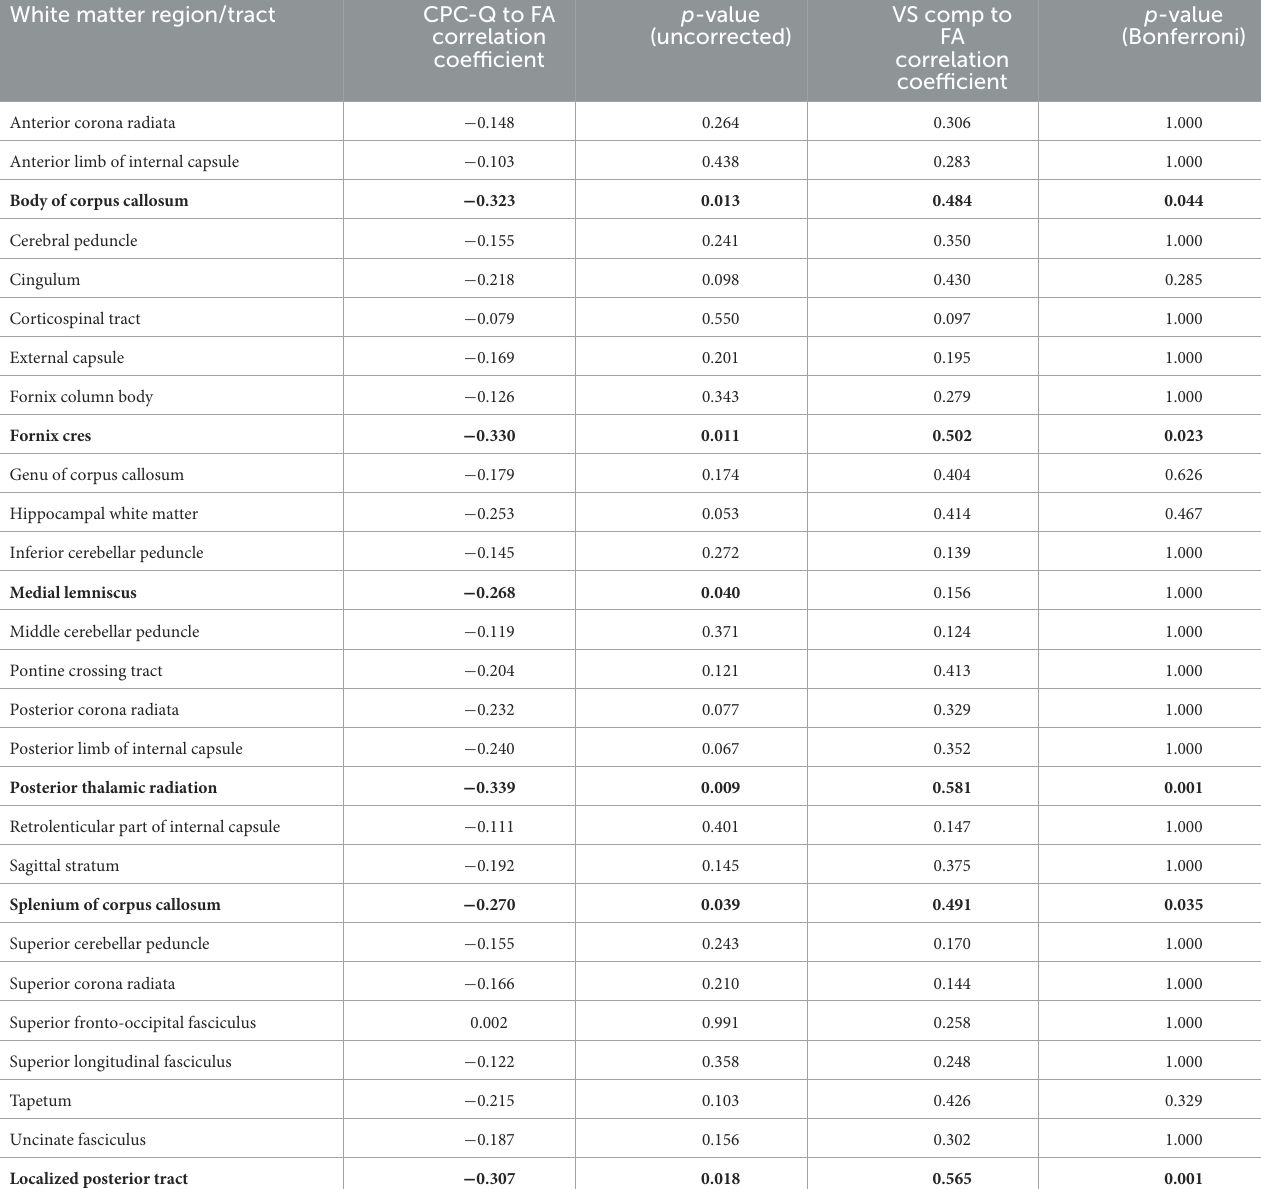
TABLE 4 Exploratory correlational analyses between mean DTI FA for all white matter region/tracts and CPC-Q and visuospatial composite scores. White matter region/tract CPC-Q to FA